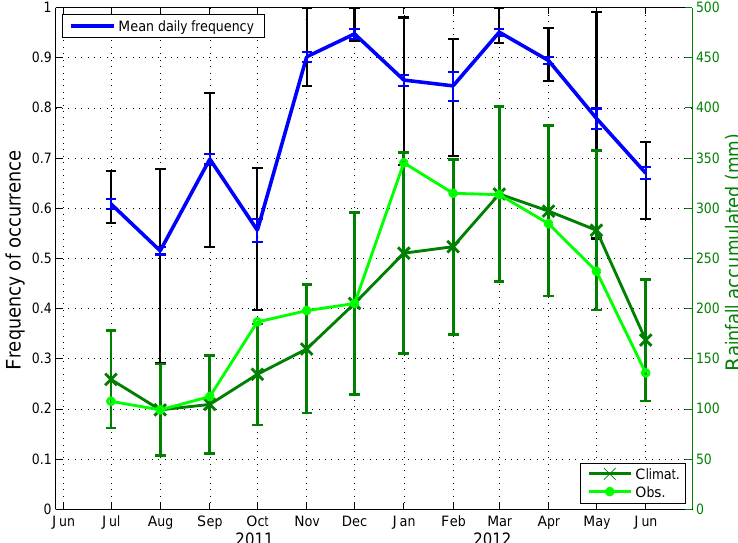
Figure 2. Monthly frequency of occurrence of cirrus clouds from July 2011 to June 2012 (blue line) with the associated statistical error (black). Accumulated (light green) and climatological (dark green) rainfall, shown on the right axis, were obtained from the TRMM 3B42 version 7 dataset averaged over an area of 10 ◦ × 10 ◦